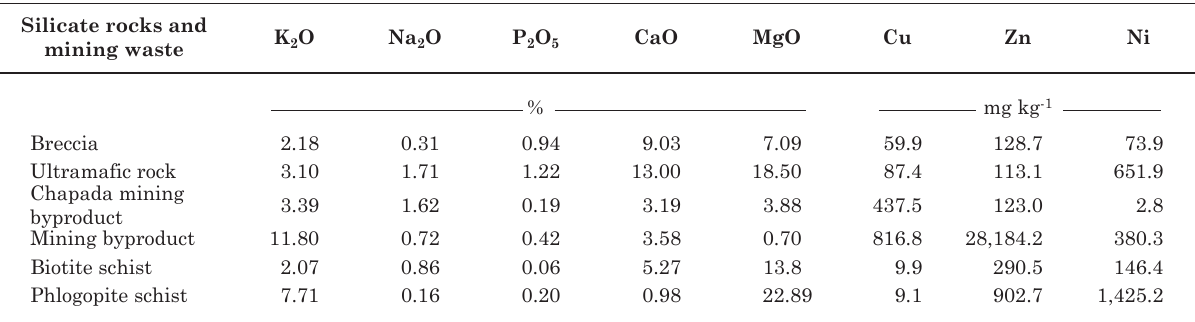
table 1. total content of k 2 o (1) , na 2 o (1) , P 2 o 5(1) , Cao (1) , mgo (1) , Cu (2) , zn (2) , and ni (2) of ground rocks and mining waste silicate rocks and mining waste